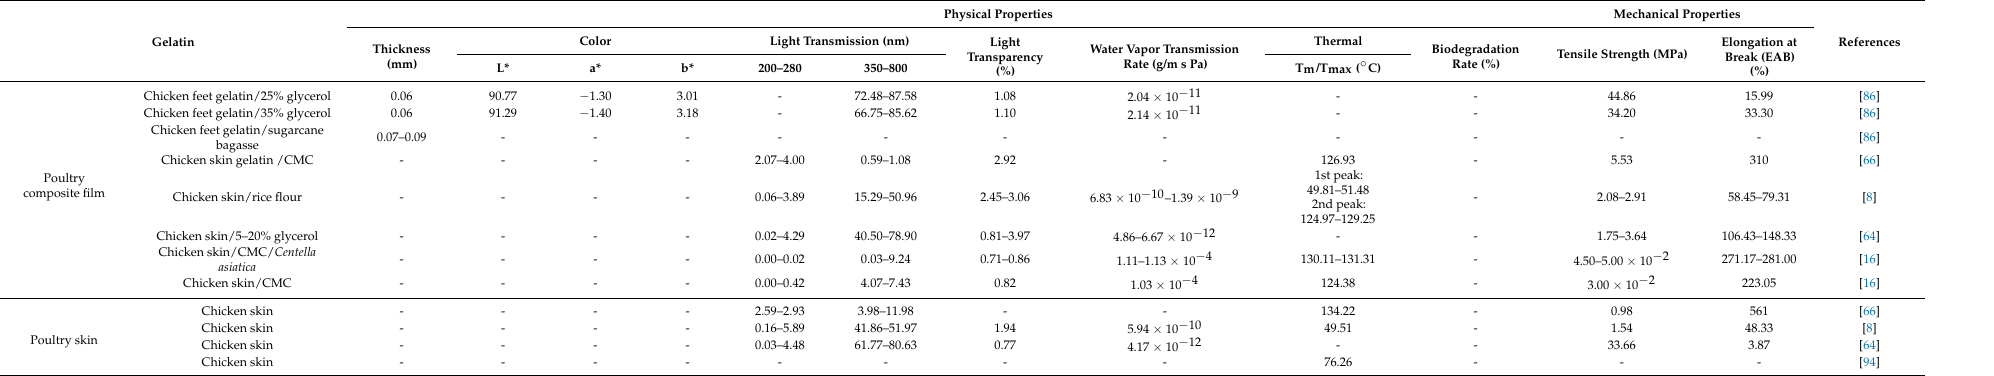
Table 3. Physical and mechanical properties of poultry gelatin-based